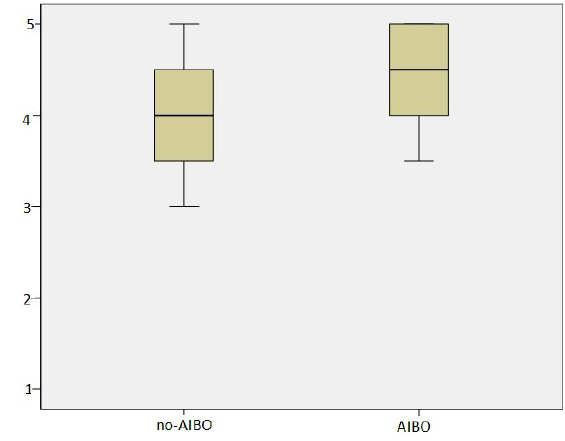
Figure 8. Story length in bytes through sessions 1 to 5 for both interaction modes. Longer stories noted for AIBO mode.